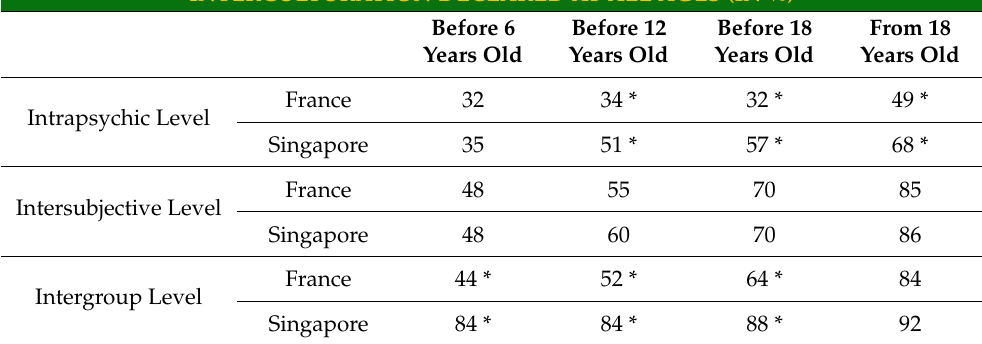
Table 1. Interculturation at all ages (figures followed by * highlight patterns where difference was found significant between French and Singaporean